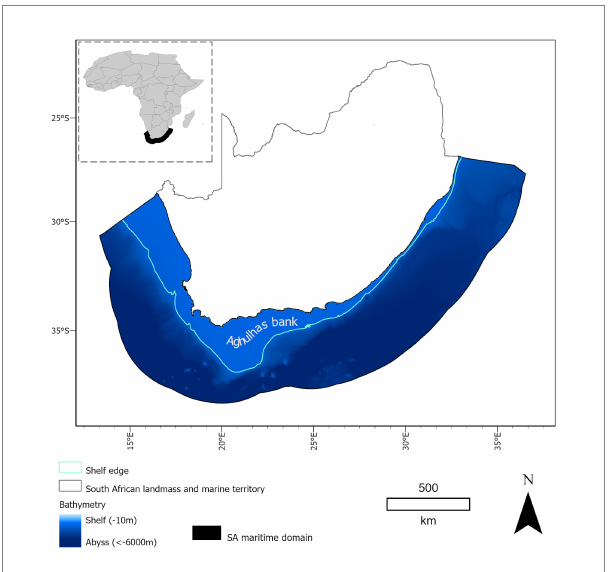
FIGURE 1 Map of the study area showing the marine realm of South Africa’s mainland